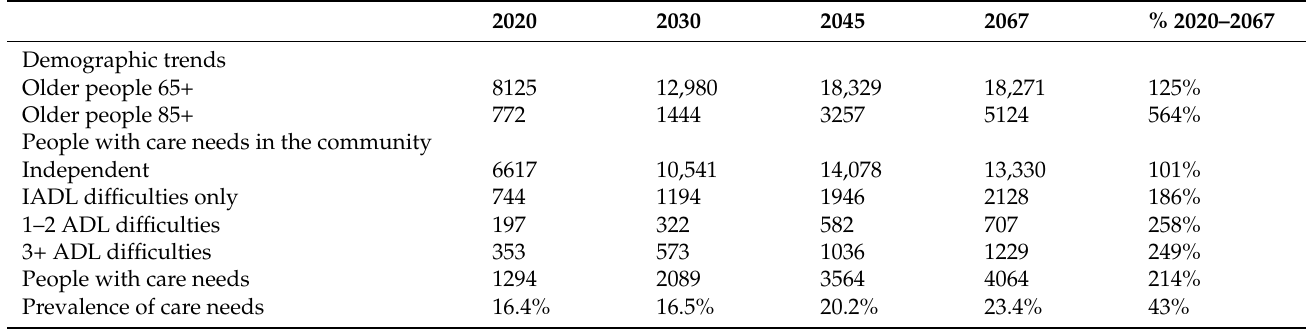
Table 3. Projected population and care needs (unit: thousand